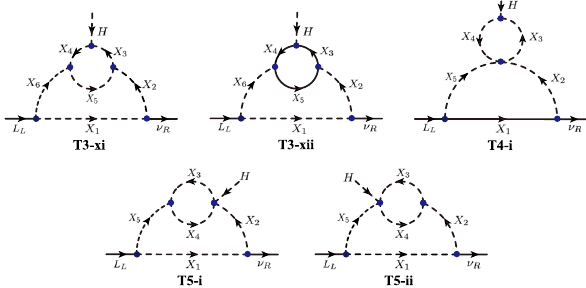
Fig. 4 Two-loop diagrams that contain a compressible scalar-scalar- scalar or a compressible scalar–vector-vector vertex. The other captions are the same as in Fig.